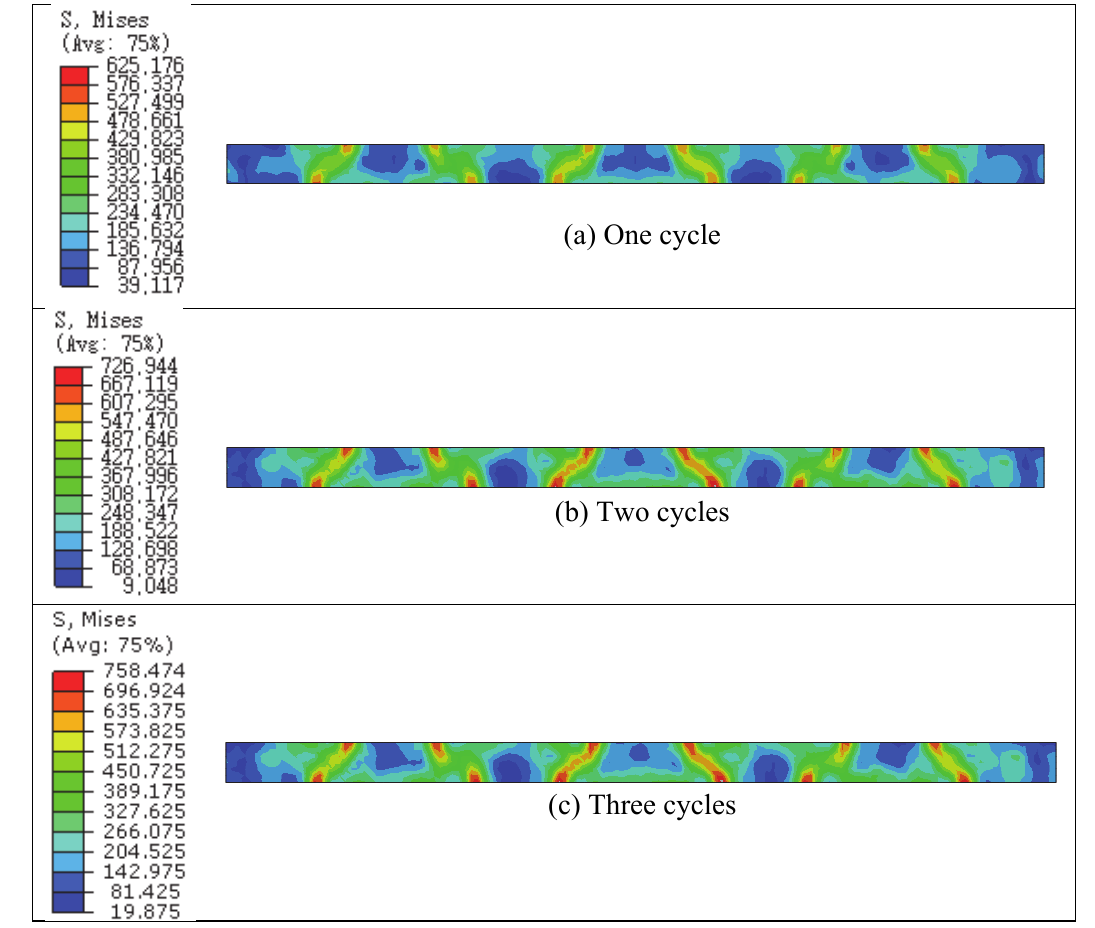
Figure 7: Distribution of Von Mises constraints for different numbers of cycles.